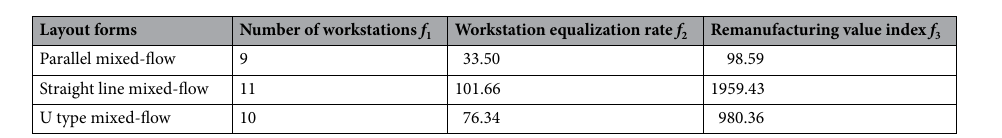
Table 6. Comparison of solution results for remanufacturing disassembly lines with different layouts.